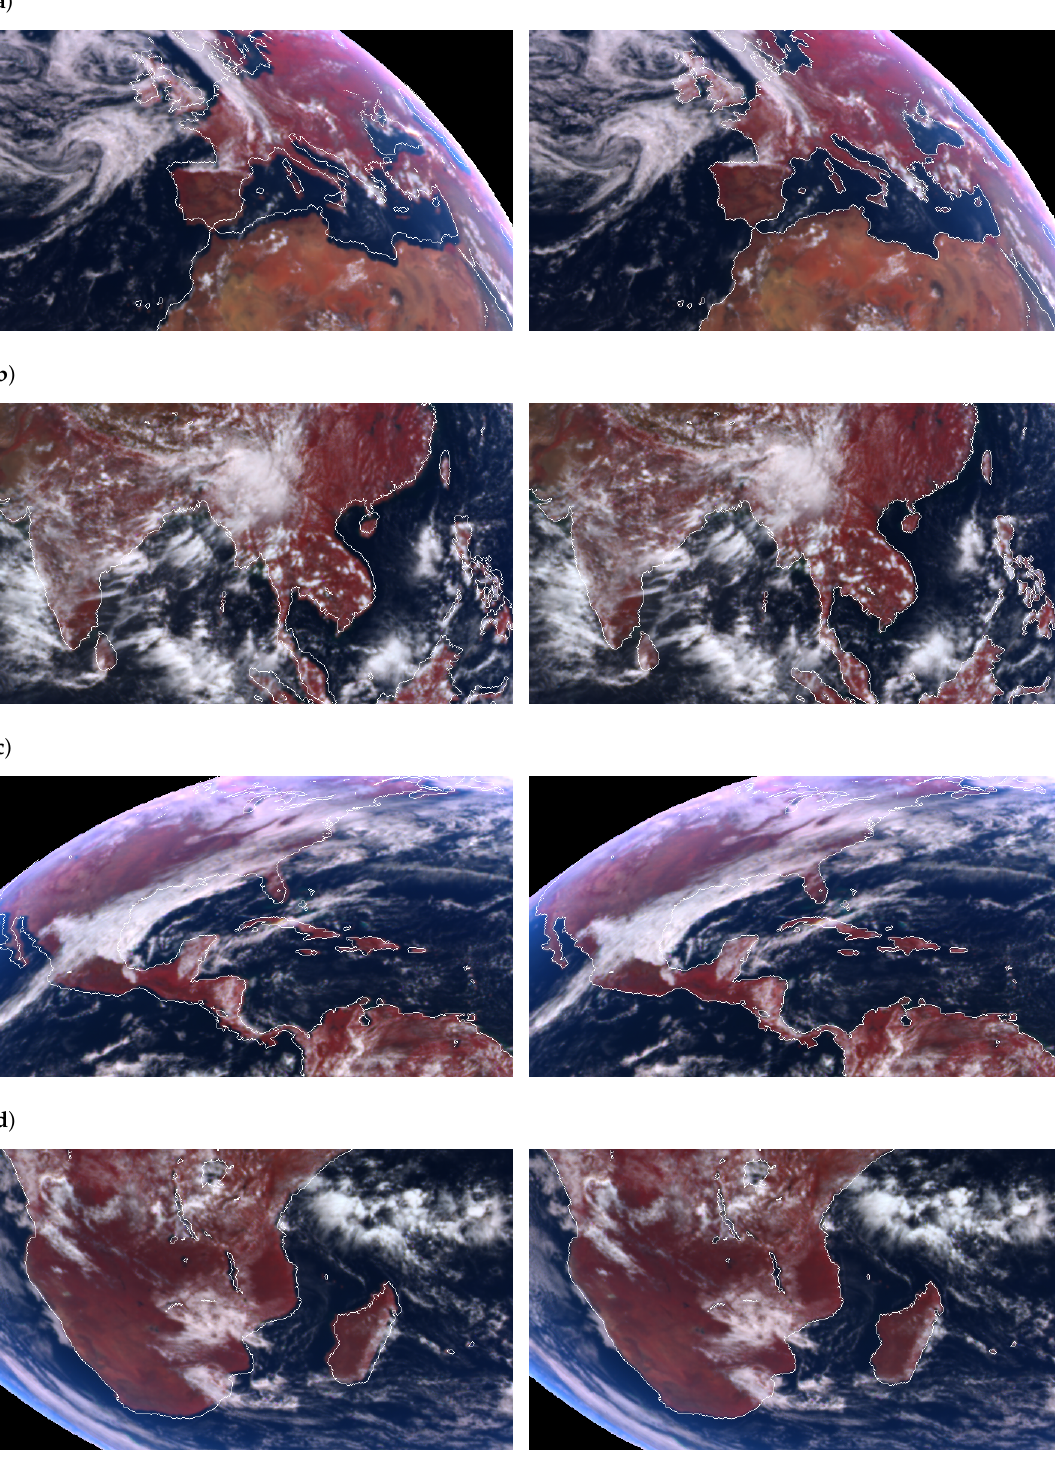
Figure 7. Examples of different reflectance images from EPIC L1B version 2 before ( left ) and after ( right ) applying the new registration: ( a ) Europe and North Africa on 4 August 2015 14:37:27 UTC; ( b ) East Asia on 24 July 2016 07:09:19 UTC; ( c ) Caribbean Sea and Gulf of Mexico on 15 December 2017 17:17:03 UTC; and ( d ) the south of Africa and Madagascar on 16 May 2018 09:10:54